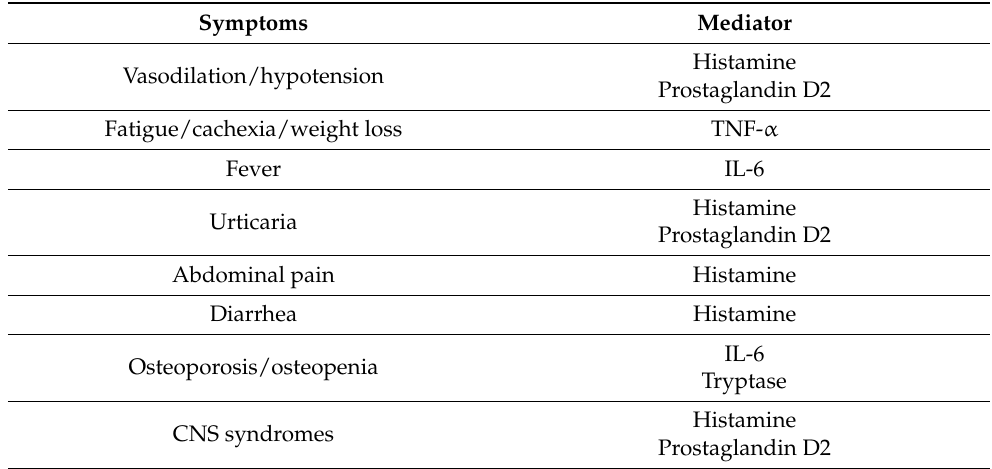
Table 4. Mast cell mediator and accompanying symptoms (according to Konrad et al.